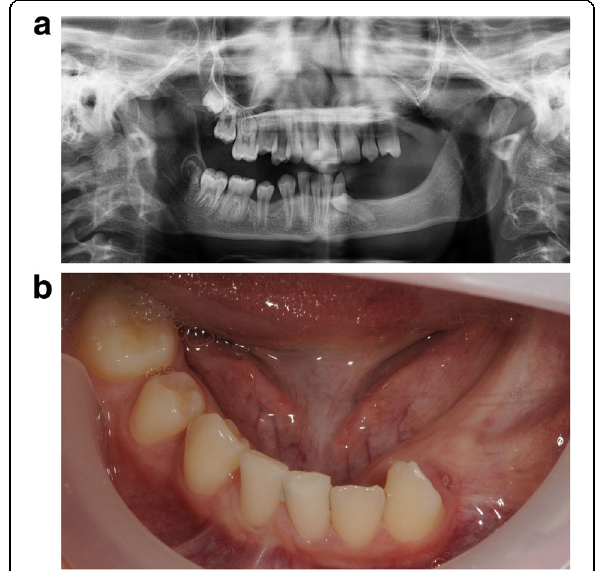
Fig. 2 a Patient 2 — pre-implant orthopantomogram (OPG) at the age of 12. Situation before start of orthodontic and implant treatment. Eleven permanent teeth (including 2 third molars) were congenitally missing and the 34 is impacted. To erect the 34, orthodontic treatment was desired. Due to the lack of stable anchorages in the third quadrant, it was decided to place one implant at tooth region 35 for orthodontic anchorage and future